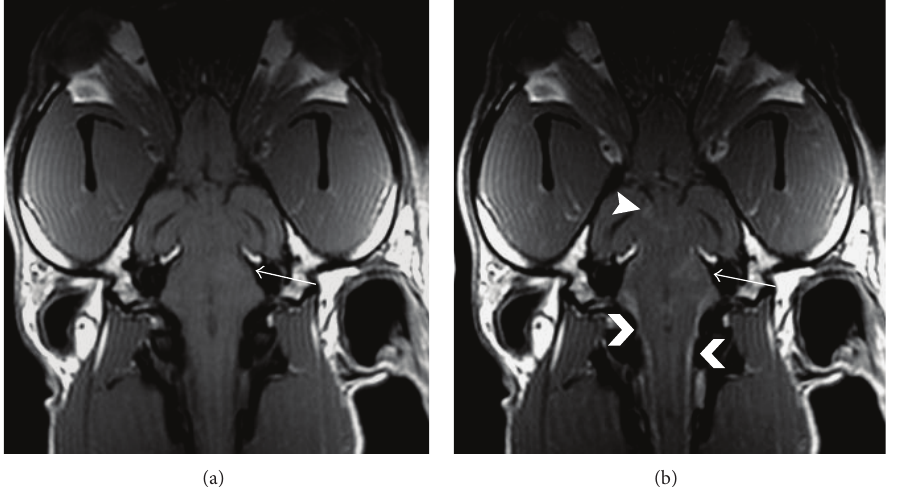
Figure 2: T1-weighted dorsal pulse sequences before (a) and after contrast (b), at the level of the brainstem. (a) On the T1-weighted precontrast images, a faint ill-defined hyperintense signal was visible in the left pons (long arrow). (b) On the T1-weighted postcontrast sequence, meningeal enhancement was observed around the pons, medulla oblongata , and cranial cervical spine (arrowheads). A broadbased enhancement was visible in the left aspect of the pons (long arrow). Faint ill-defined enhancing lesions were also observed in the right frontal lobe (solid